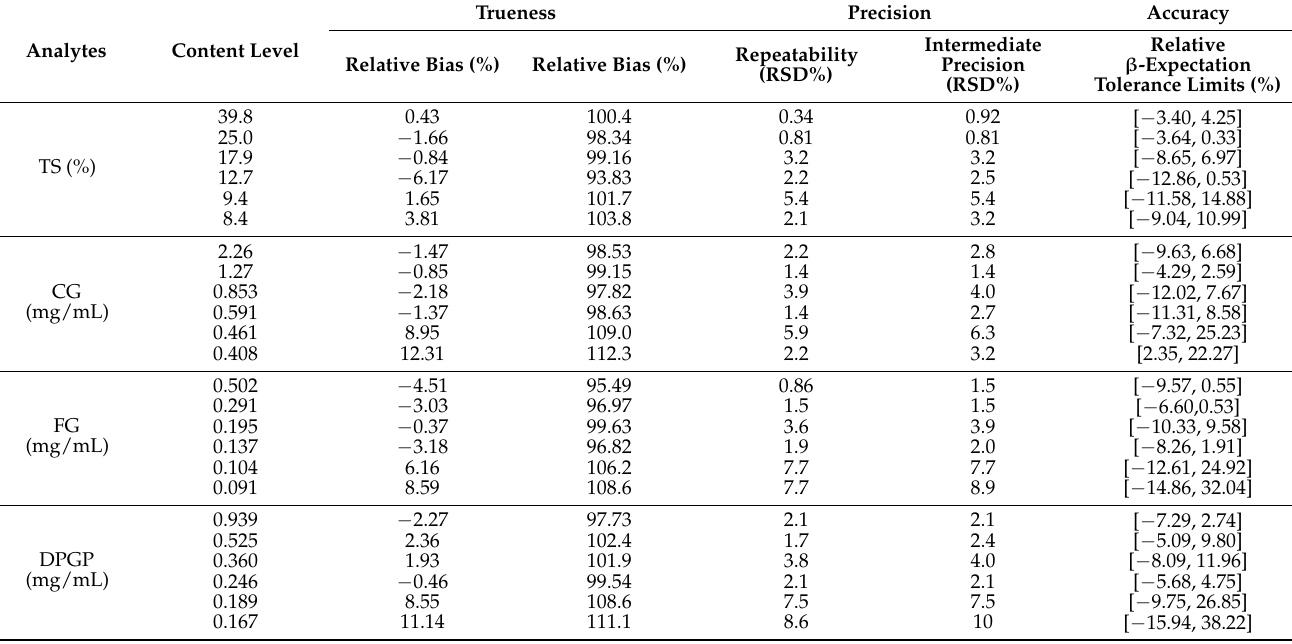
Table 6. Validation criteria of trueness, precision, and accuracy of the models for the 7